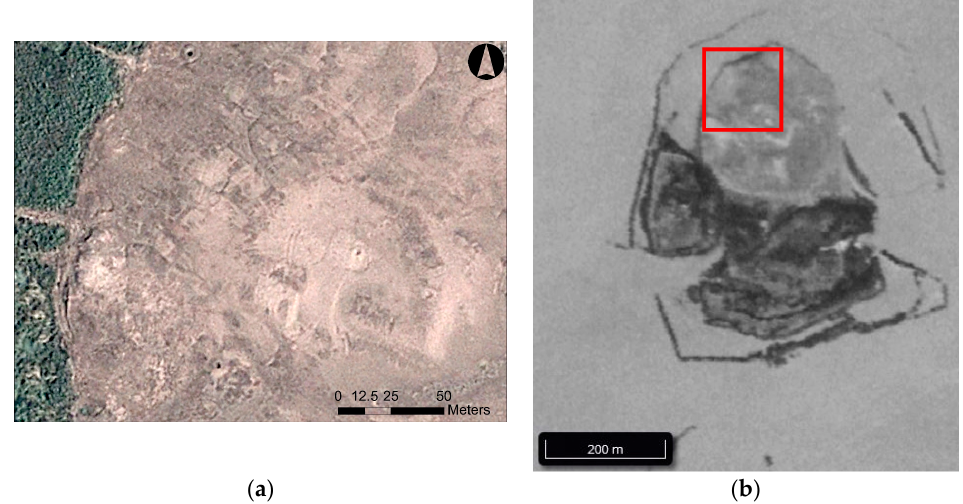
Figure 20. ( a ) The site of Tell el-Gassa Image courtesy Google Earth; ( b ) 1968 CORONA image. The area of image ( a ) is in the red box. Image courtesy of the Center for Advanced Spatial Technologies, University of Arkansas/U.S. Geological Survey.